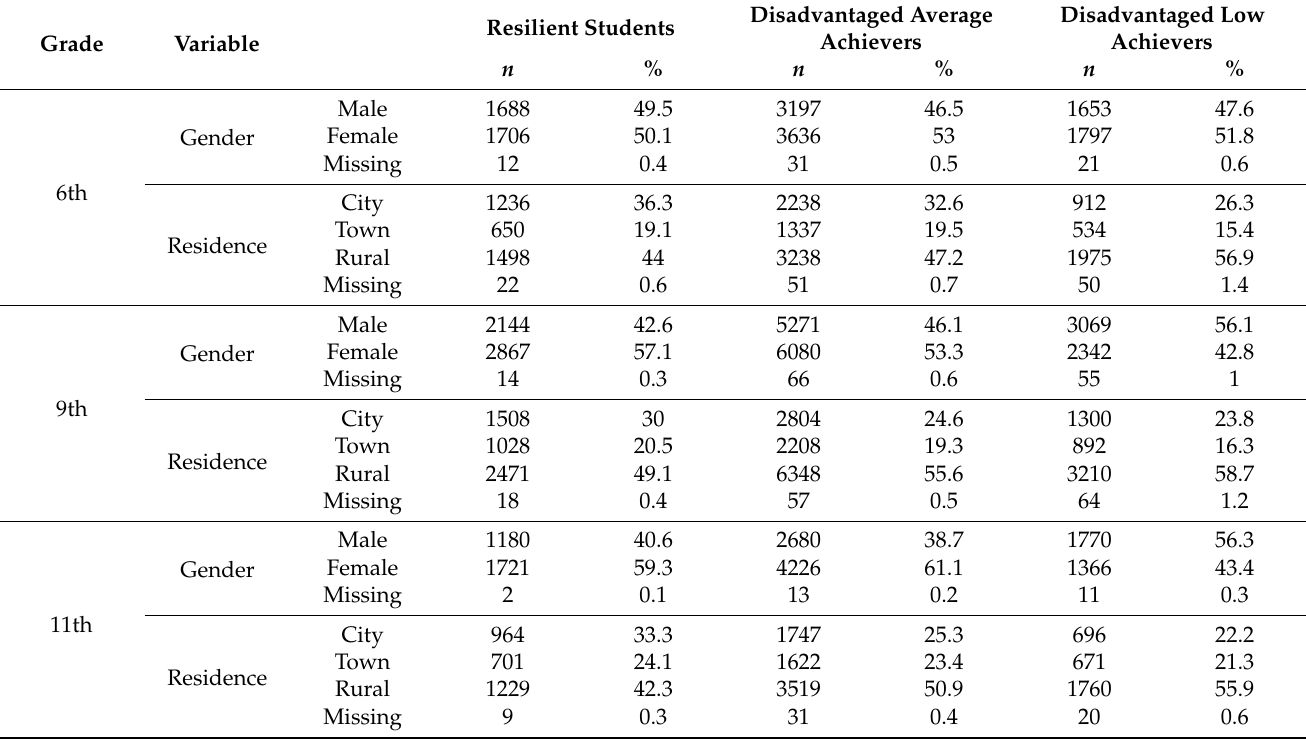
Table 1. Descriptive statistics of disadvantaged students in each